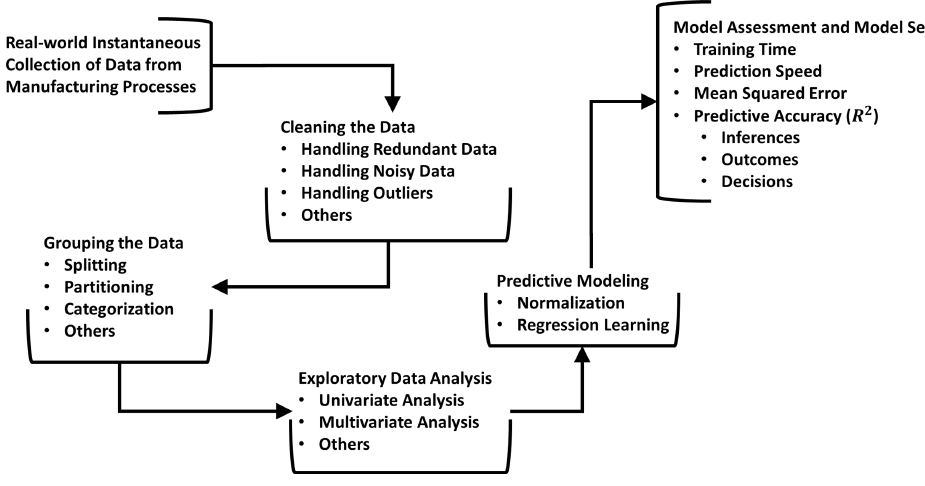
Figure 1. The proposed generalized